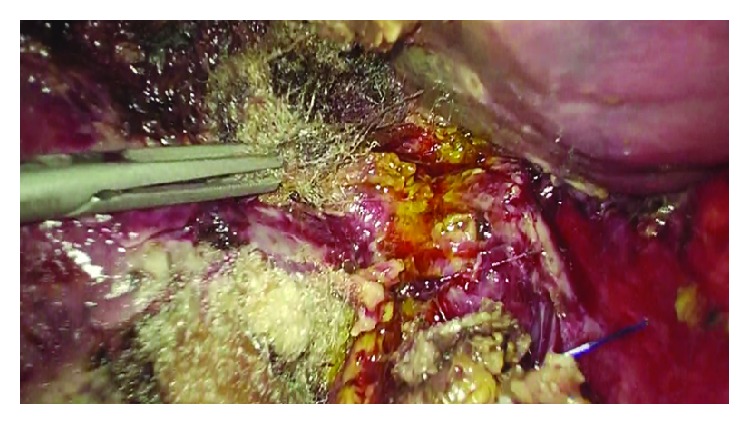
Duct of Luschka.